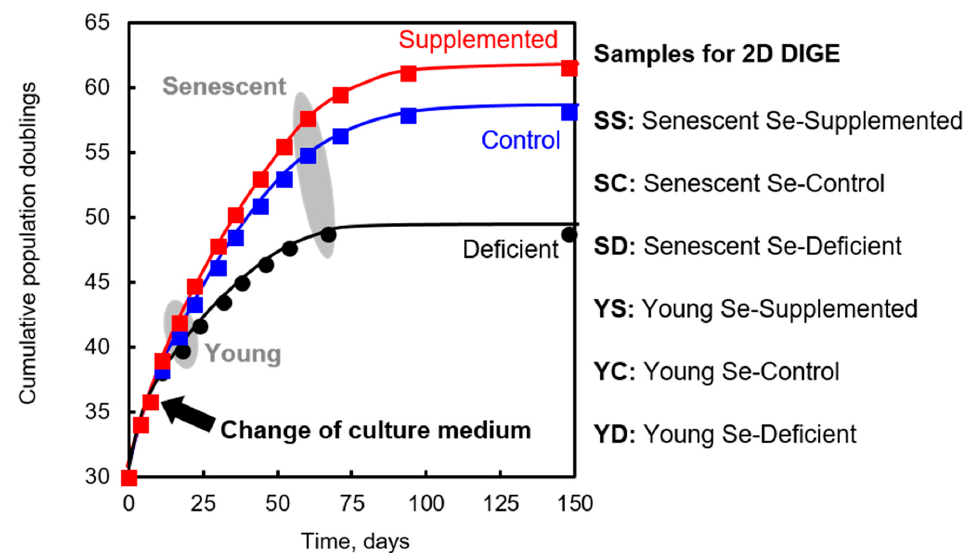
Figure 1. Figure 1. The replicative life span of WI-38 cells is affected by the selenium level of the culture medium. At cumulative population doublings (CPD) 35.8, WI-38 cells were plated in three different conditions, namely, Se-deficient (Dpl, black dots), Se-control (Ctl, blue square), and Se-supplemented (Sup, red square) for two passages and until they reached the senescent stage. The gray ellipses illustrate the time and stage the cells were harvested for 2-Dimensional Differential in-Gel Electrophoresis (2D-DIGE)